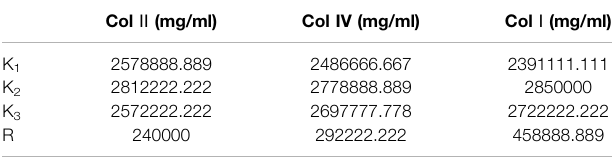
TABLE 2 | Range analysis of collagenases combinations on cell count during kidney tissue digestion.